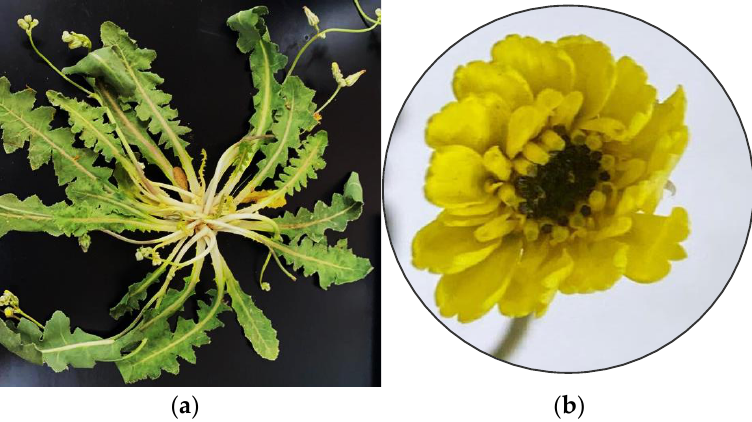
Figure 3. Photograph of Launaea capitata (Spreng.) Dandy; ( a ) whole plant, ( b ) the flower.